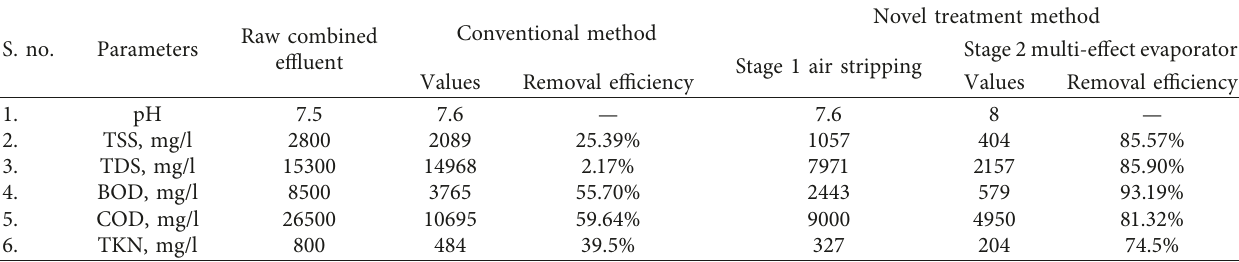
Table 2: Comparison of pharma effluent